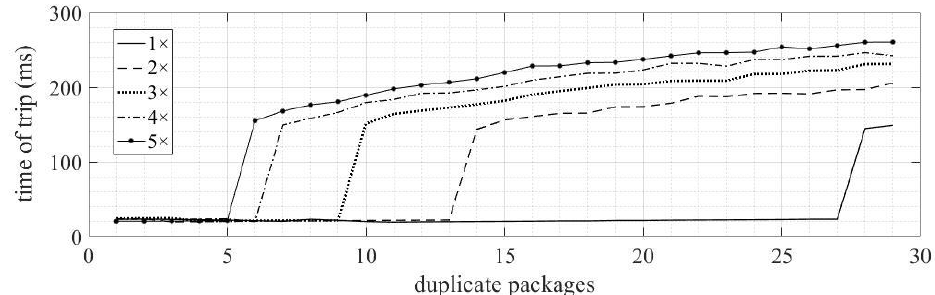
Figure 14. Tripping time results ANSI 50 — duplicated packets.